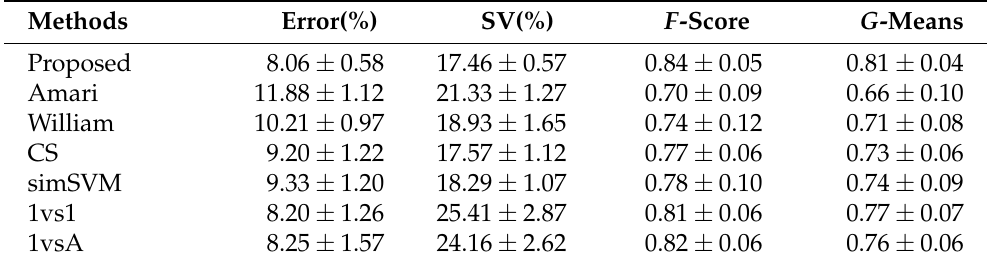
Table 4. Outcomes of multi-class prediction on the Prostate Cancer